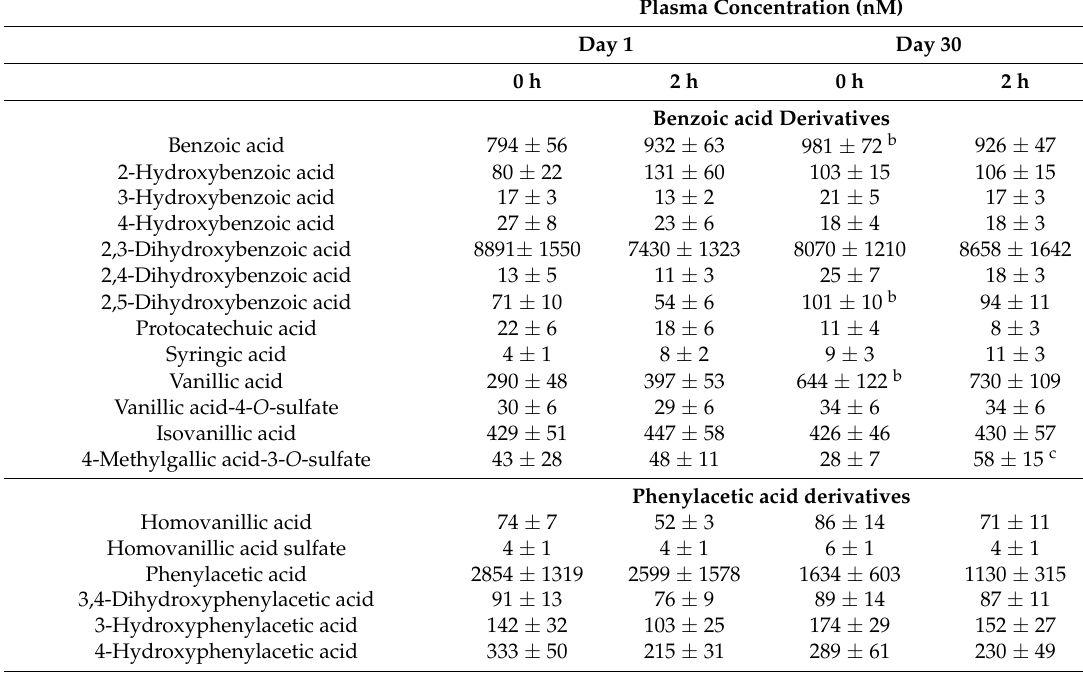
Table 2. Plasma (poly)phenol concentration at 0 and 2 h post-consumption of wild blueberries ( n = 18) after acute (day 1) and repetitive intake (day 30). Compounds which had statistically higher plasma concentrations at 2 h when compared to 0 h on day 1 (acute) are marked with a . Statistical significant plasma concentrations when comparing 0 h at day 30 with 0 h on day 1 (chronic) were marked with b and statistical significance at 2 h on day 30 when compared to 0 h on the same day (acute + chronic) are marked with c